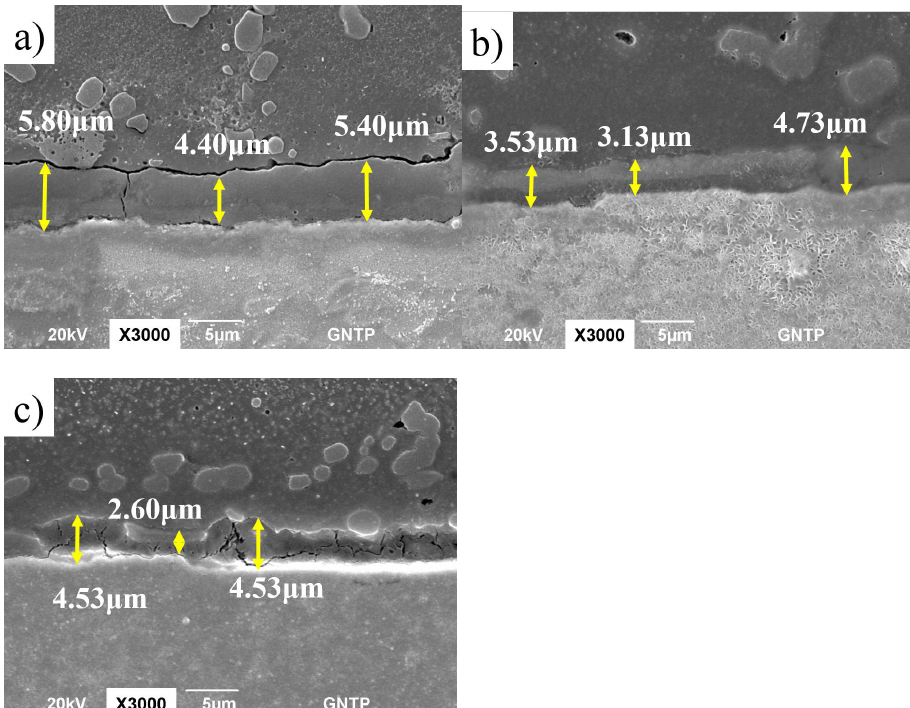
Figure 4. SEM pictures according to TPD of experiment group A. ( a ) TPD = 0.0 mm; ( b ) TPD = 0.5 mm; and ( c ) TPD = 1.0 mm.